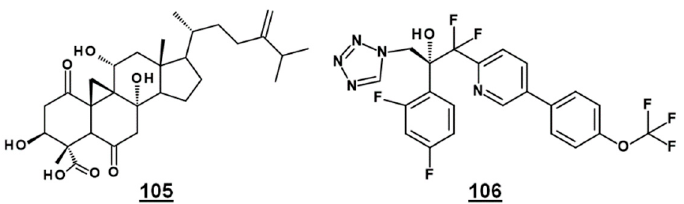
Figure 12. EBIs FR171456 105 and VT-1129 106 , confirmed by sterolomic analysis.